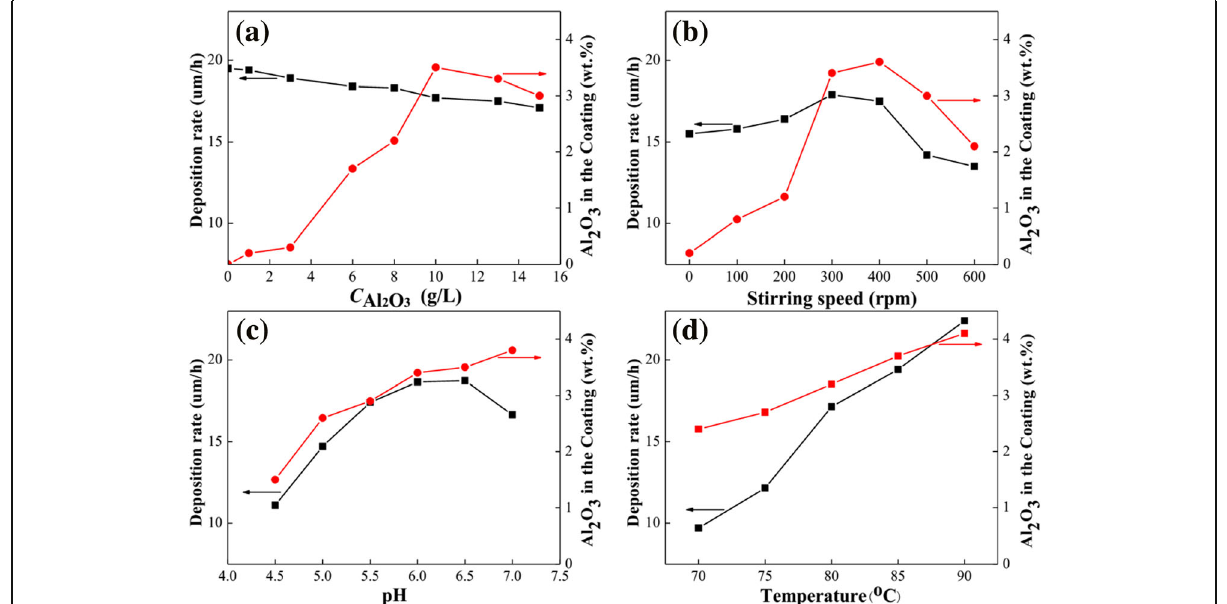
Fig. 1 Effects of process parameters on deposition rate and Al 2 O 3 content of